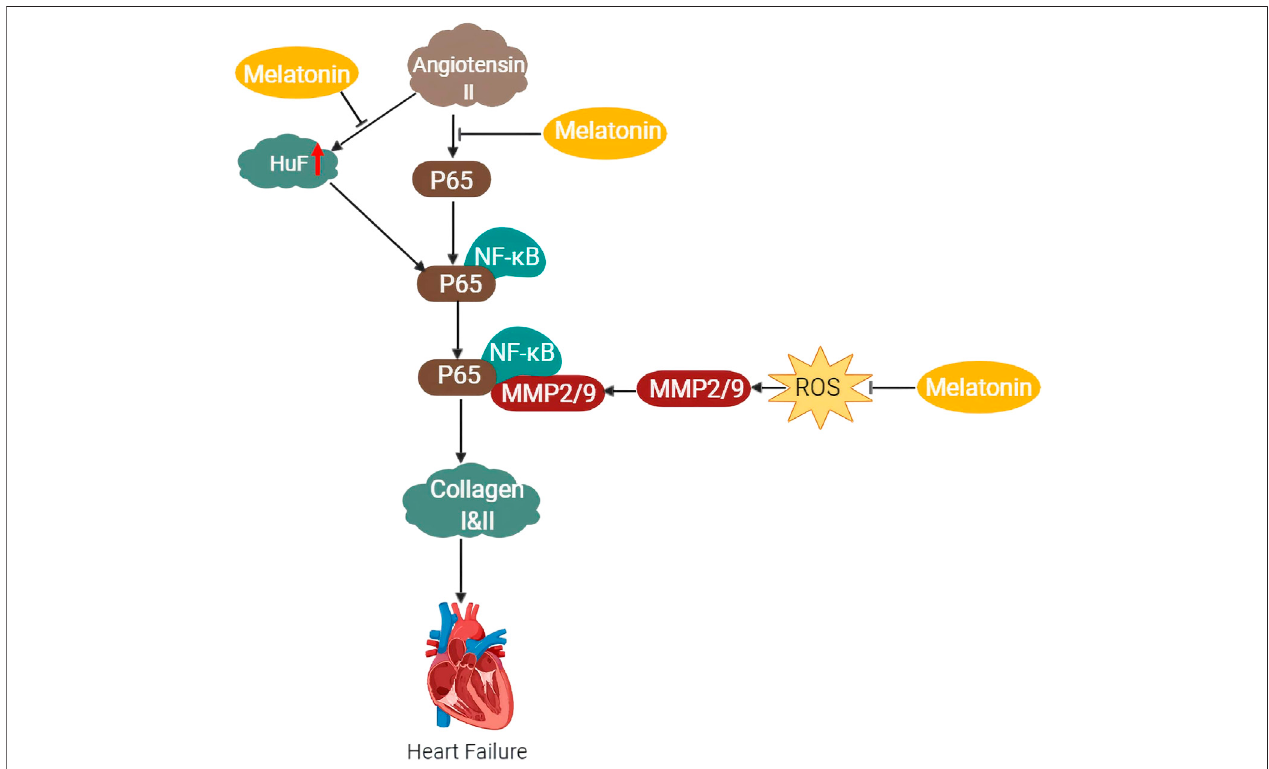
FIGURE 4 | Schematic diagram of the proposed mechanism of the protective effects of melatonin against heart failure via inhibition of NF-kB and MMP2/9 pathways.